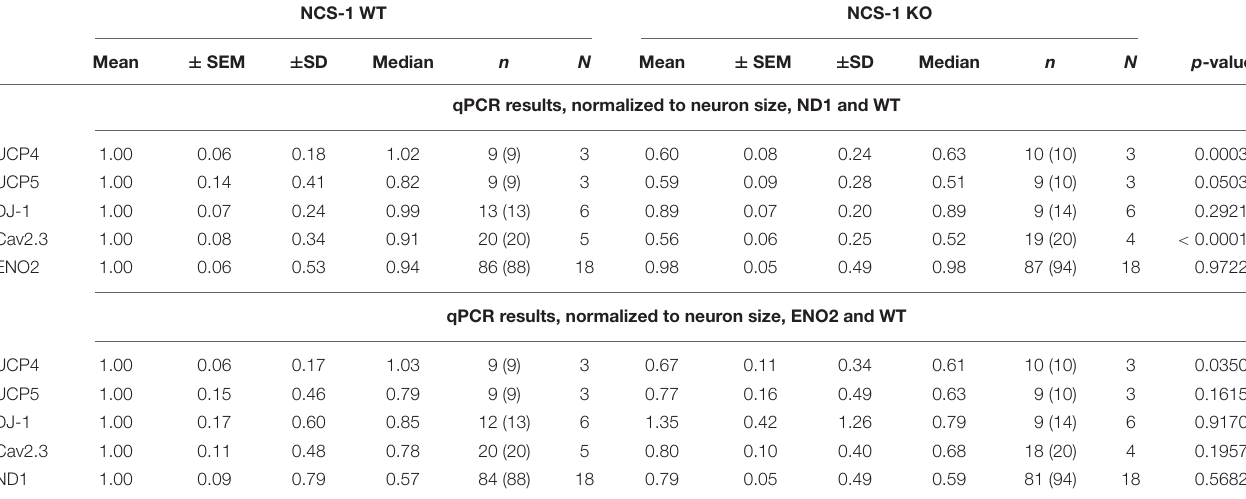
TABLE 3 | Relative mRNA levels in SN DA neurons of NCS-1 KO and WT, normalized to cell sizes, in respect to that of ND1 or